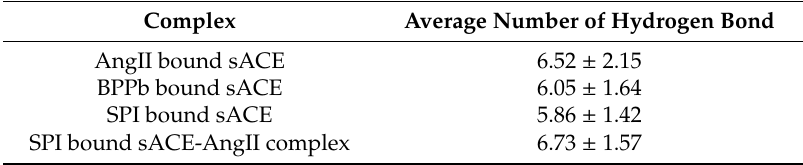
Figure 4. Comparison of the distances between two lips among the Apo and ( a ) competitive inhibitor bound forms with AngII and BPPb. ( b ) Mixed non-competitive inhibitor bound forms with SPI and SPI-AngII complex. Table 1. The average number of hydrogen bonds between the ligand and the enzyme calculated over the production stage of molecular dynamics (MD) simulations.